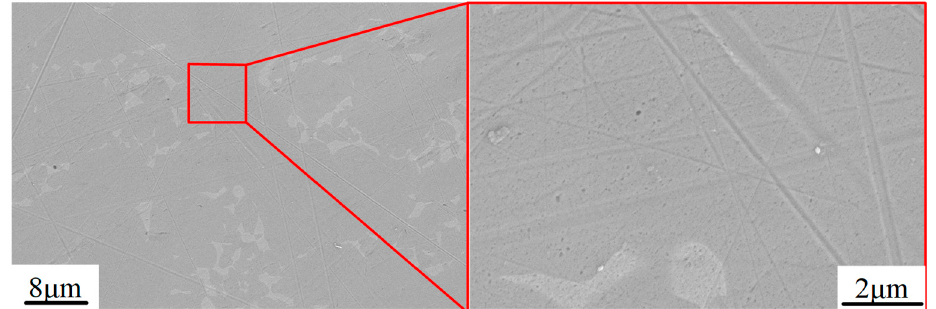
Figure 14. SEM morphology of Ti6Al4V alloy after uniform polishing.